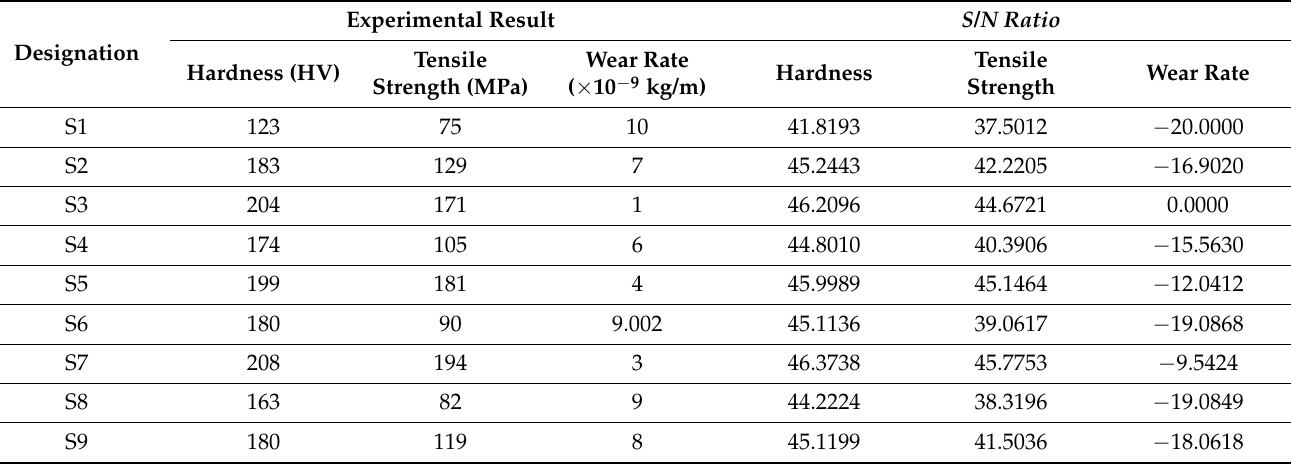
Table 10. Experimental results and S/N ratio of hardness, tensile strength, and wear rate